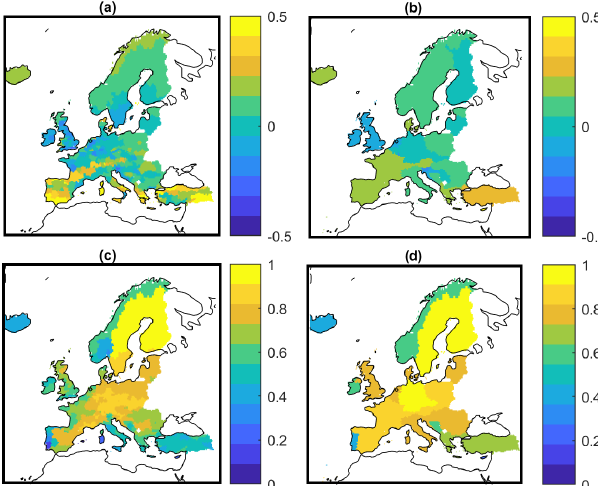
Figure 5. (a, b) Symmetric percentage error ς on average snow- fall (c, d) Correlation coefficient R 2 for the SF daily snowfall time series for ERA5 and E-OBSv20.0e. (a, c) NUTS-2 level, (b, d) NUTS-0